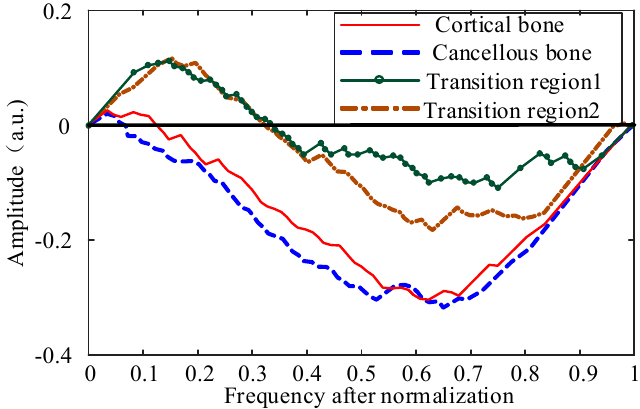
Figure 7. The new curve representing the relationship between the amplitude and the frequency after conversion and normalization for different bone layers. Each of the curves corresponds to the curves shown in Figure 5.